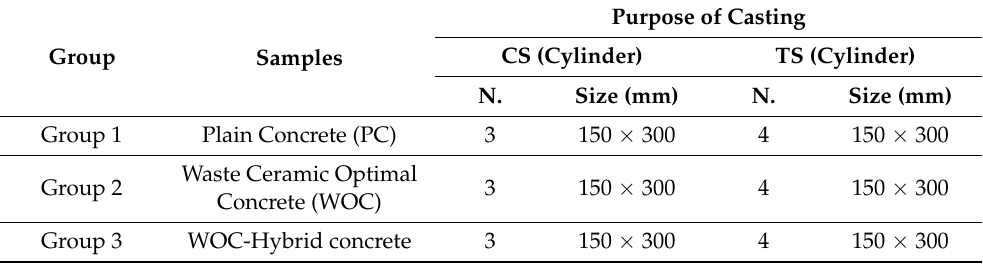
Table 5. The total used symbols in the present study.